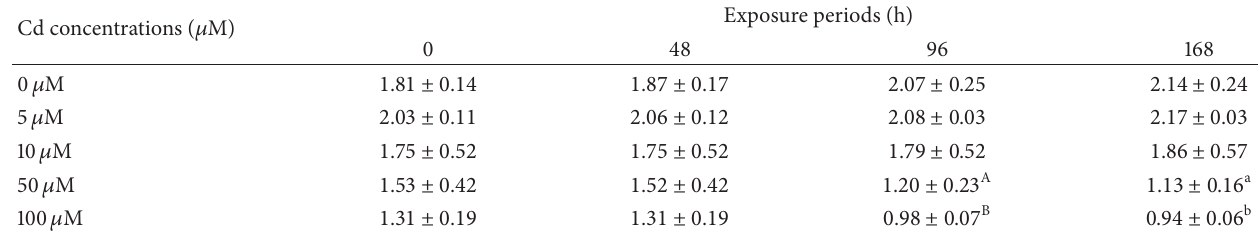
Table 1: Effect of cadmium on biomass (gfw) in B. monnieri at different concentrations and exposure periods. Cd concentrations ( 𝜇